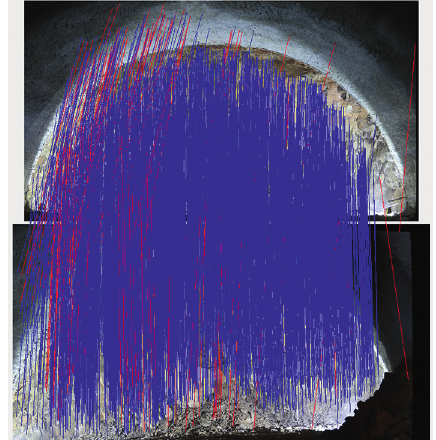
Figure 7: Feature point matching results. The blue lines in the figure are the matches that meet the preset threshold condition, and the red lines are the matches that do not meet the preset threshold